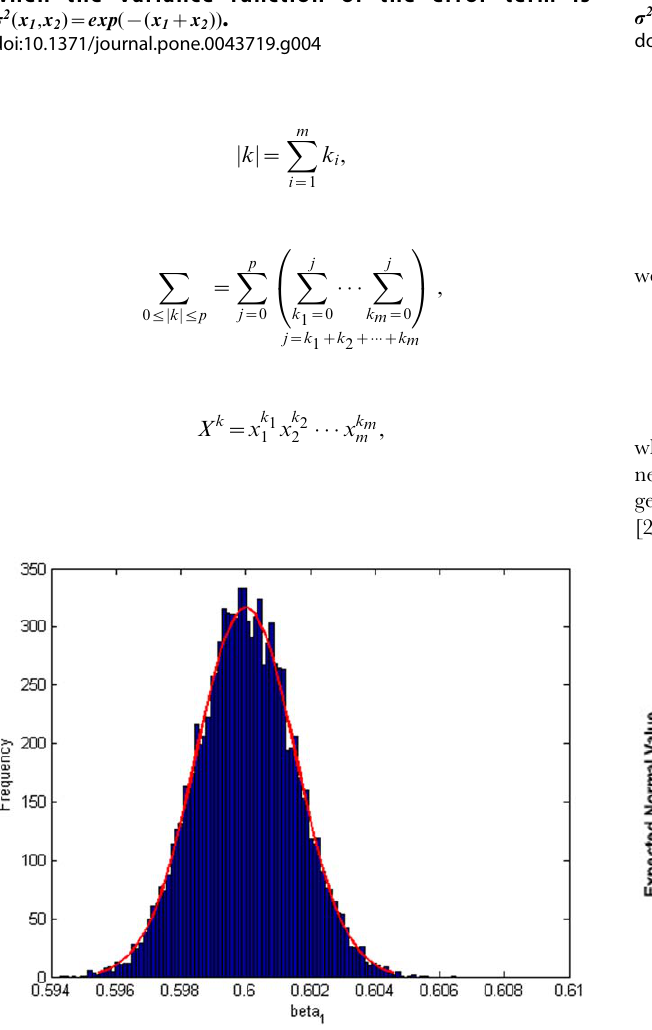
Figure 7. Normal Q-Q plot of residuals of ^ bb 0 of GLS when the variance function of the error term is s 2 ( x 1 , x 2 ) ~ exp ( { ( x 1 z x 2 )) .